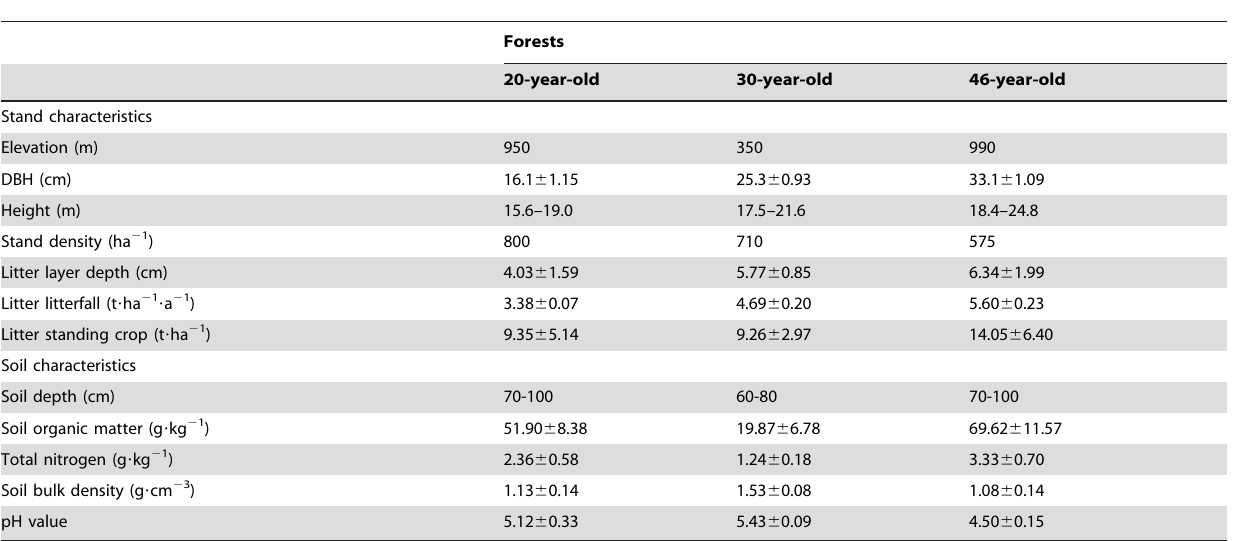
Table 1. Summary of stand and site characteristics measured in summer 2010 (mean 6 1 SD; n = 3).